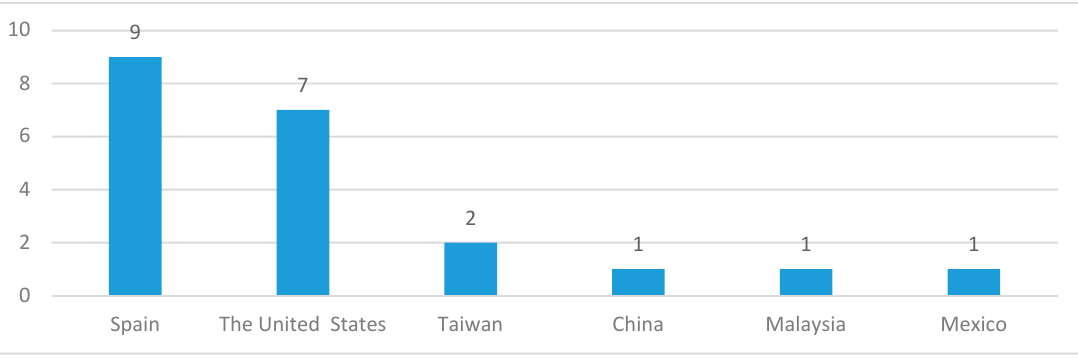
Figure 2. The number of studies published by country and regions.